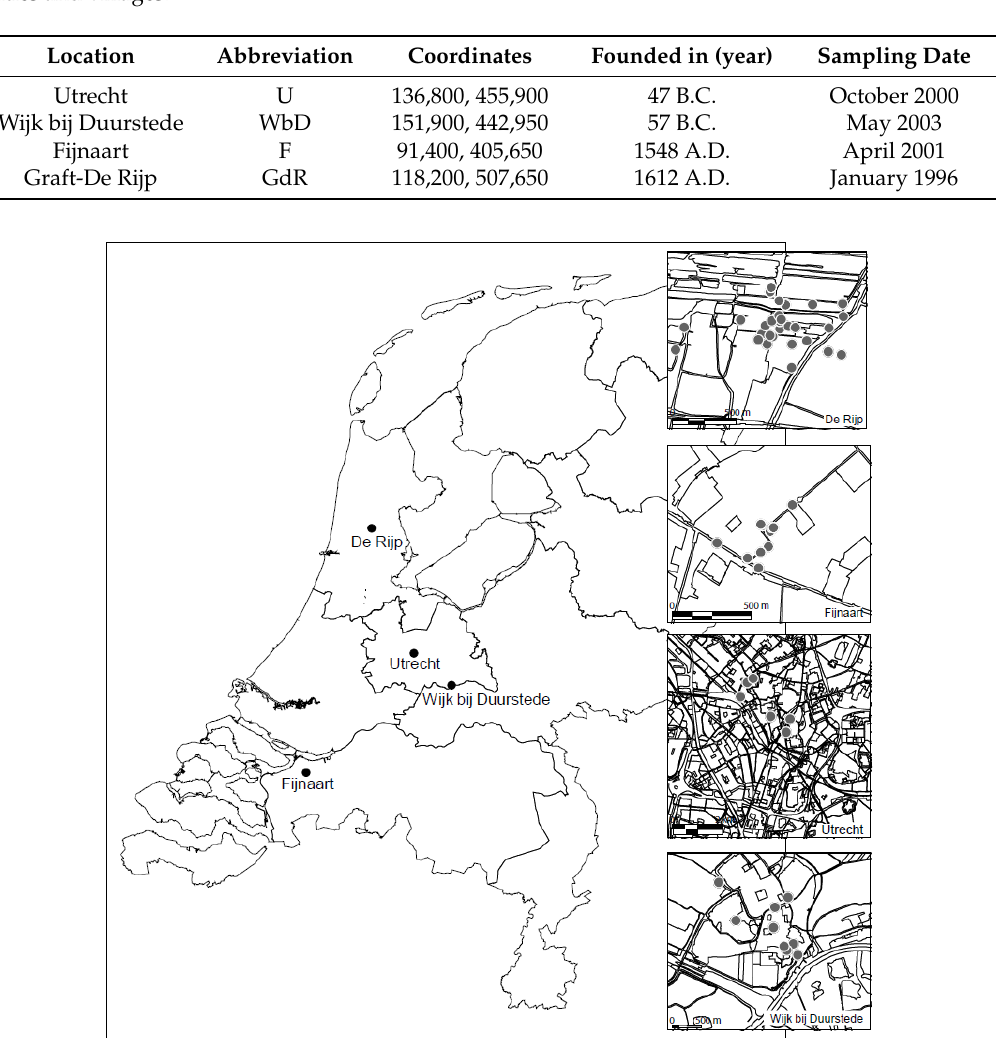
Figure 1. Sample locations of the Pb polluted soils and potential anthropogenic Pb sources.